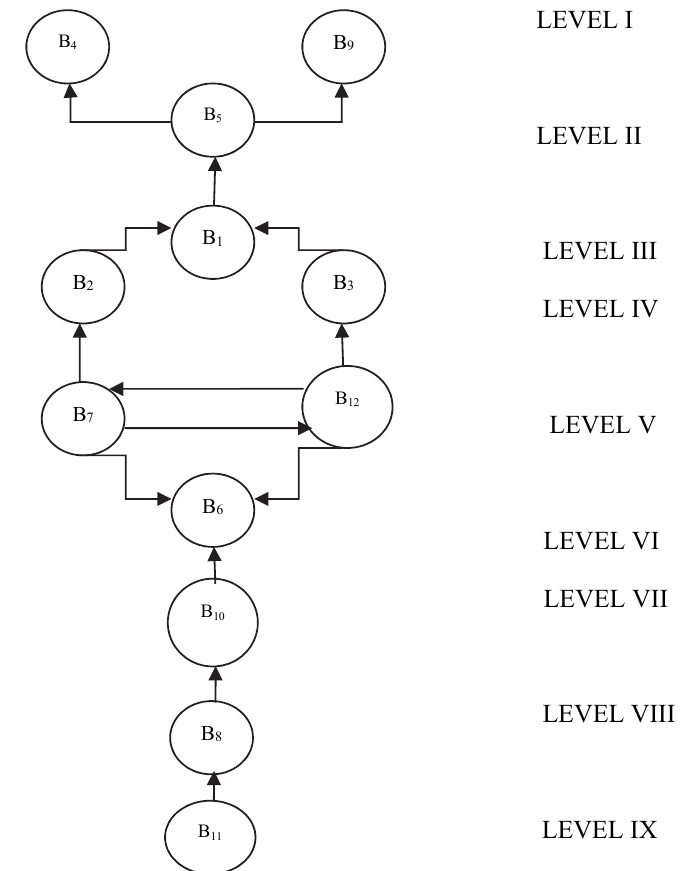
Fig. 2. Digraph of barriers affecting utilization of QT&T in manufacturing